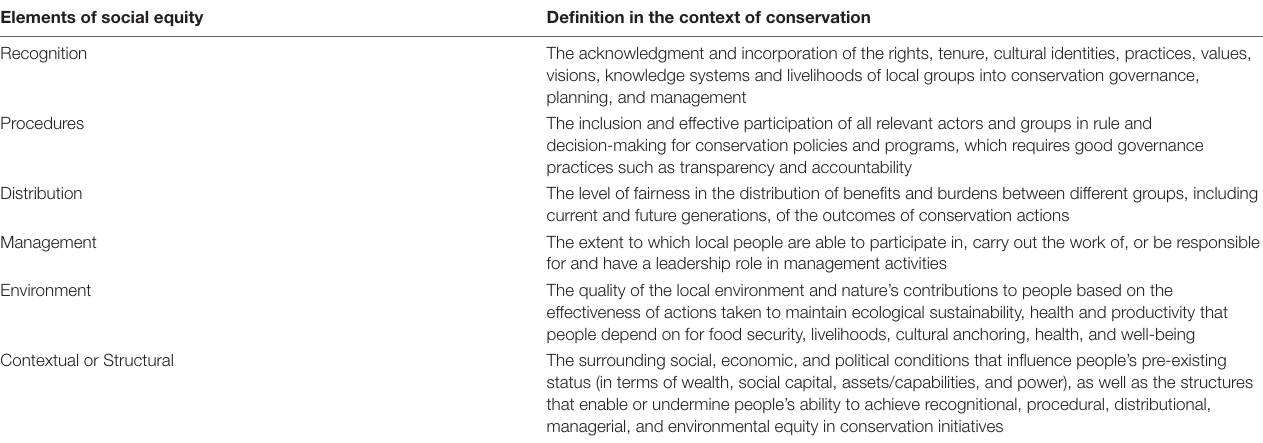
TABLE 1 | Definitions of the elements of social equity in the context of marine conservation (McDermott et al., 2013; Pascual et al., 2014; Schreckenberg et al., 2016; Zafra-Calvo et al., 2017; Dawson et al., 2018; Bennett et al., 2020). Elements of social